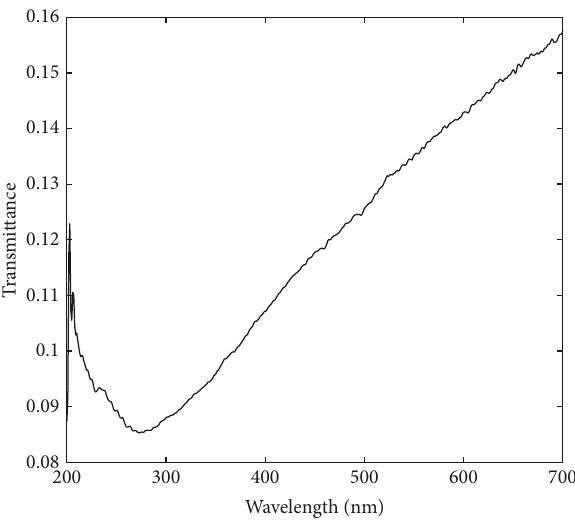
Figure 3: Transmittance UV-vis